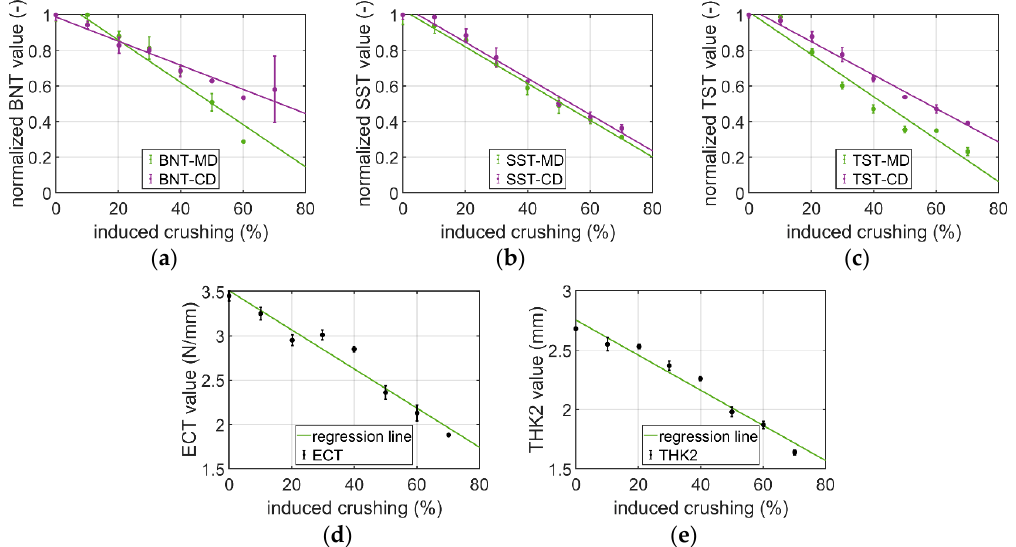
Figure 10. The decreases in measured values for B-285 corrugated cardboard in: ( a ) BNT; ( b ) SST; ( c ) TST; ( d ) ECT and ( e ) THK2.